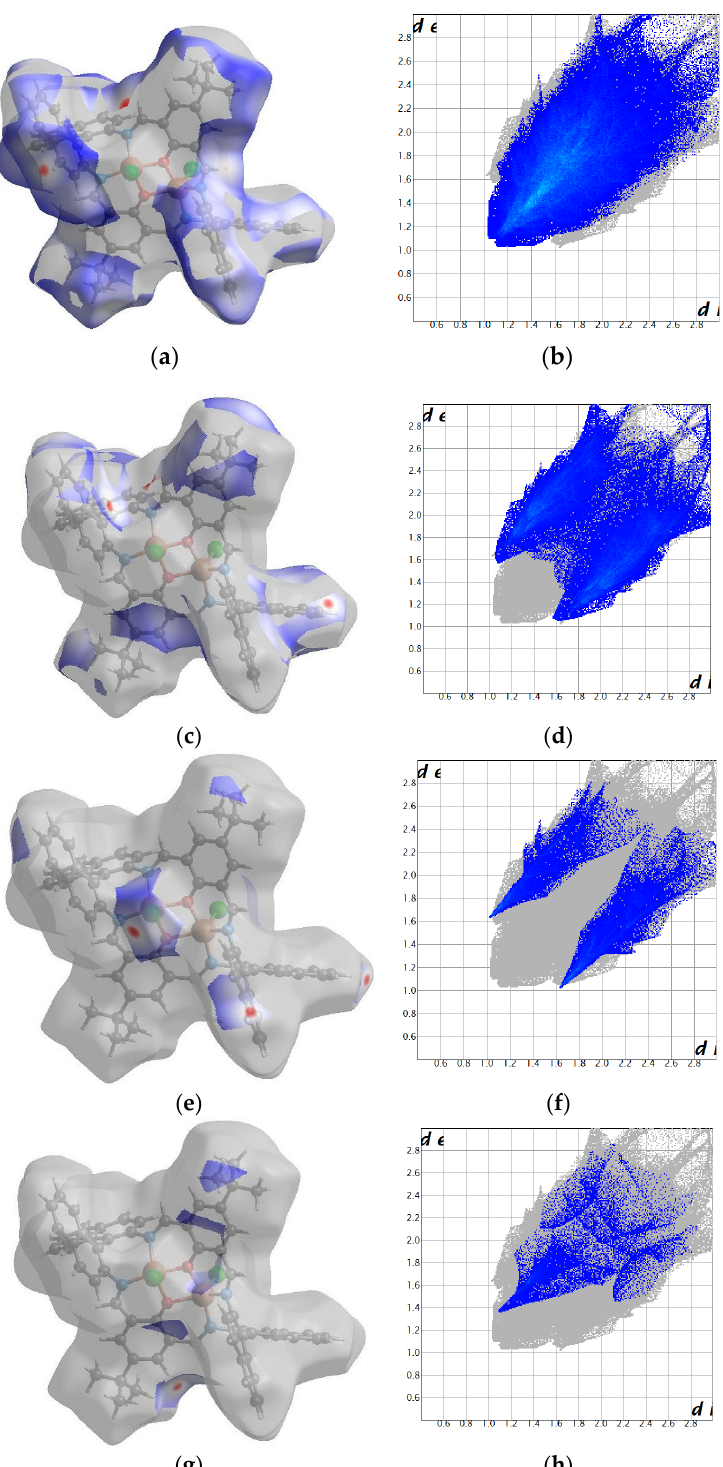
Figure 6. Hirshfeld surfaces and fingerprints of selected interactions created in the crystal network of K2 : Hirshfeld surface ( a ) and fingerprint ( b ) for H…H (54.2%), Hirshfeld surface ( c ) and K2 : Hirshfeld surface ( a ) and fingerprint ( b ) for H . . . H (54.2%), Hirshfeld surface ( c ) and fingerprint fingerprint ( d ) for H…C (28.4%), Hirshfeld surface ( e ) and fingerprint ( f ) for H…Cl (9.0%), and ( d ) for H . . . C (28.4%), Hirshfeld surface ( e ) and fingerprint ( f ) for H . . . Cl (9.0%), and Hirshfeld Hirshfeld surface ( g ) and fingerprint ( h ) for H…O (3.6%). In brackets, there is a given surface area surface ( g ) and fingerprint ( h ) for H . . . O (3.6%). In brackets, there is a given surface area included included as a percentage of the total surface area. as a percentage of the total surface